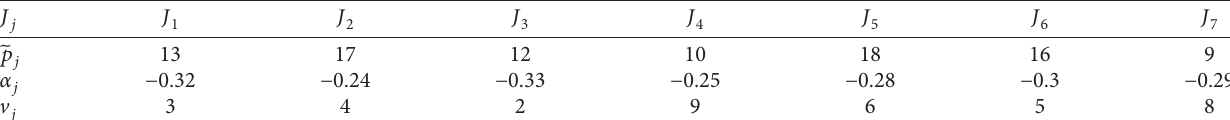
Table 4: Values Ψ